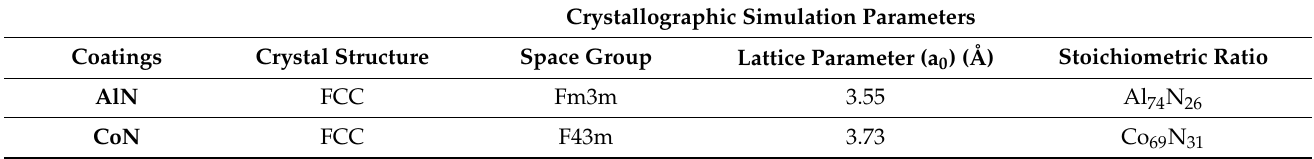
Table 3. Crystallographic Simulation parameters for AlN and CoN